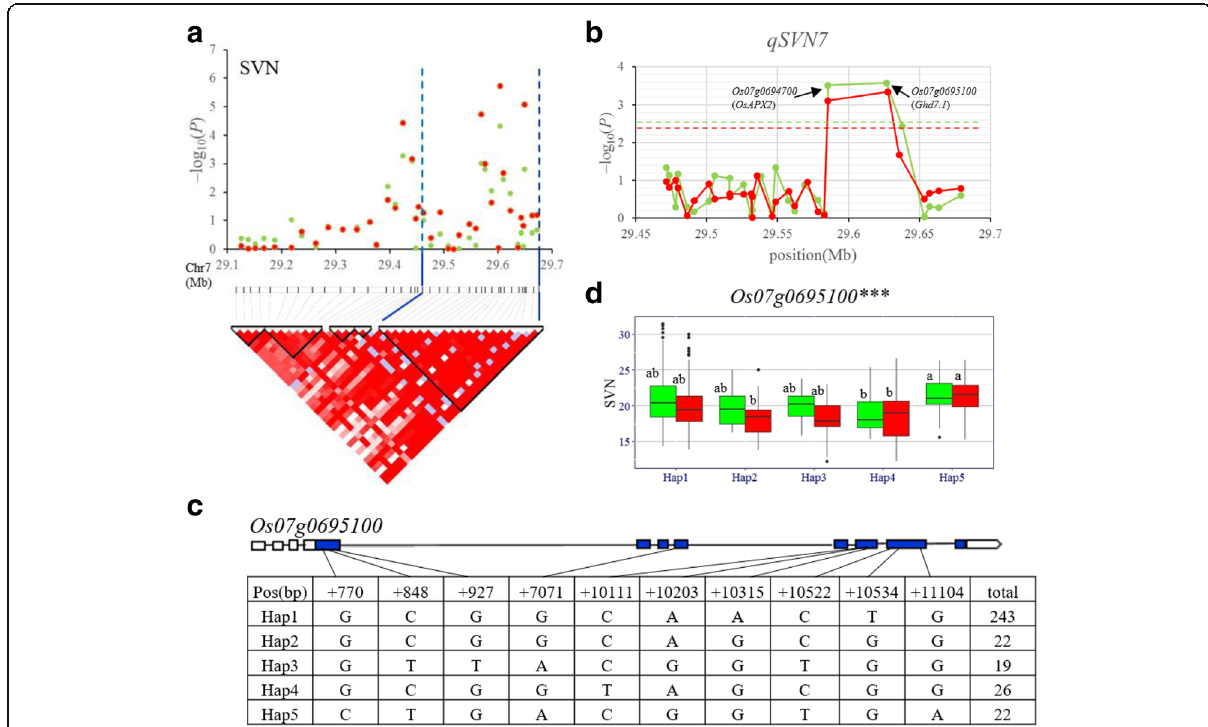
Fig. 5 Gene-based association analysis and haplotype analysis of targeted genes related to qSVN7 . a Local Manhattan plot (top) and LD block (bottom) surrounding the peak on chromosome 7. Dashed lines indicate the candidate region for the peak. b Gene-based association analysis of targeted genes related to qSVN7 . Each point is a gene indicated by one SNP having largest – log10 ( P ) value. Dash line show the threshold to determine significant SNP. c Exon-intron structure of Os07g0695100 and DNA polymorphism in that gene. d Boxplots for LVN based on the haplotypes (Hap) for Os07g0695100 . The *** suggest significance of ANOVA at P <0.001. The letter on histogram ( a , and b ) indicate multiple comparisons result at the significant level 0.05. Green and red colors indicate in 2015 and 2016,